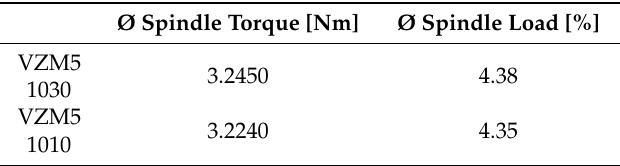
Table 20. Summary of occurring spindle torque of the hard machining tests, for inserts of type 1030 and 1010.